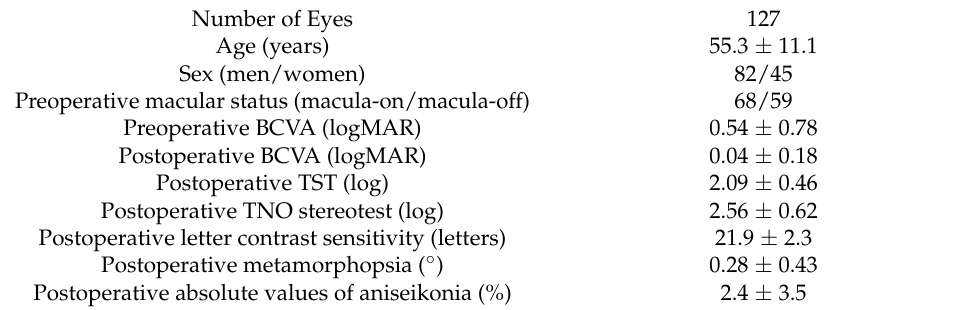
Table 1. Clinical features and visual functions in patients with retinal detachment (RD).